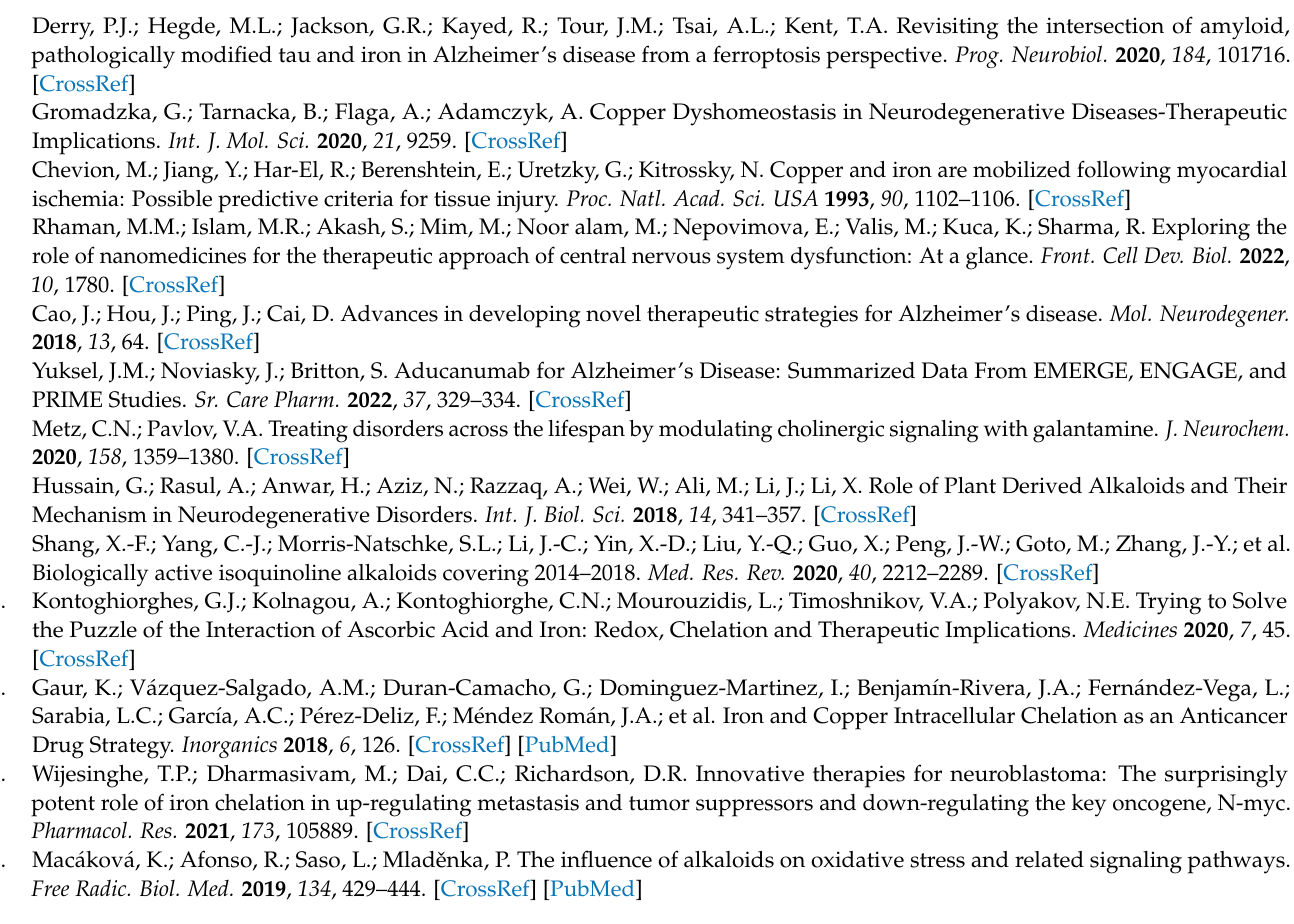
Supplementary Materials: The following are available online at https://www.mdpi.com/article/10 .3390/molecules27196429/s1, Figure S1. Structures of studied isoquinoline alkaloids. Figure S2. Sta- bility of iron complexes. Figure S3. Illustrative examples of shift of glaucine spectra after addition of ferric ions. Figure S4. Examples of comparisons between reduction lines. Figure S5. Schematic simpli- fied comparison of the most potent ferric reducing alkaloids at pH 4.5. Figure S6. Schematic simplified comparison of the most potent cupric-reducing alkaloids. Supplementary Table S1. Summarized data on the first absorption maxima of glaucine and its complexes with ferric ions. Supplementary Table S2. Significance of iron- and copper-reduction ability of